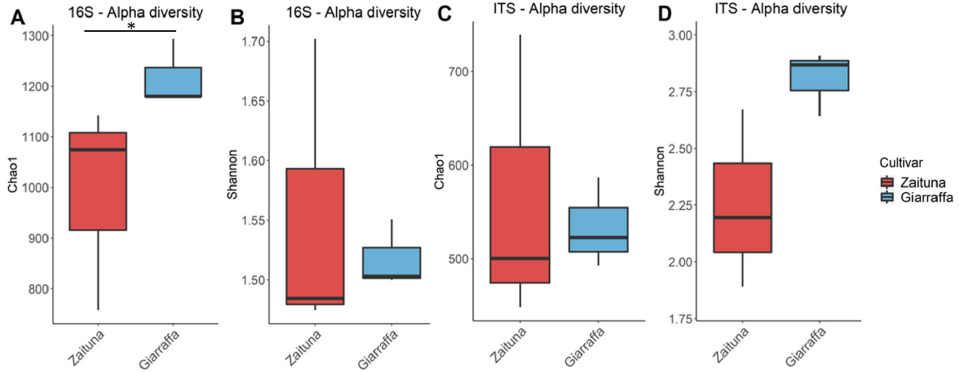
Figure 5. Alpha diversity of the bacterial ( A , B ) and fungal communities ( C , D ) in cvs. Zaituna and Giarraffa using the Chao1 and Shannon indices to evaluate richness and diversity, respectively. The Kruskal–Wallis test was performed considering the p -value (*, <0.05) to evaluate the statistical significance between the two cultivars for both the Chao1 and Shannon